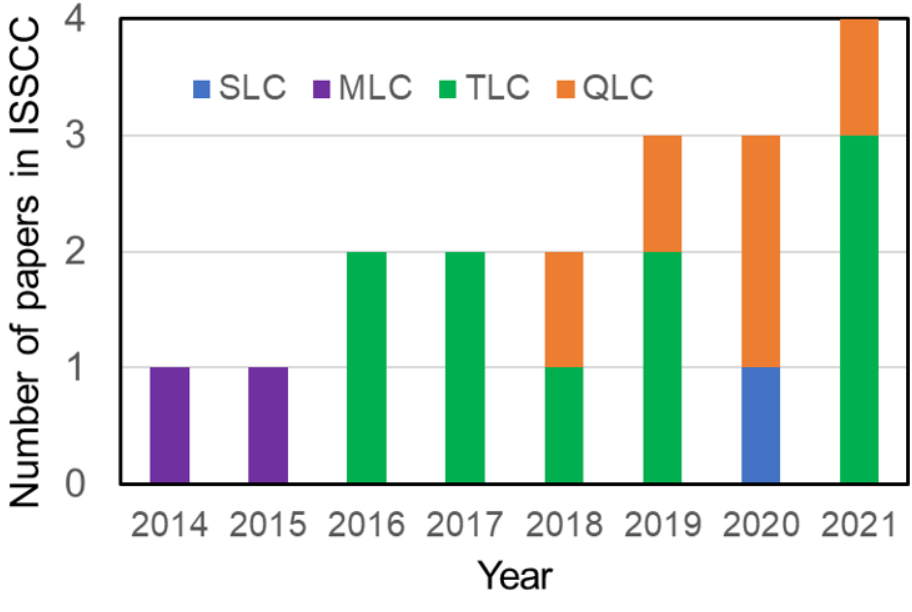
Figure 14. 3D NAND publications in ISSCC for SLC, MLC, TLC and QLC technologies. TLC has been the mainstream for 3D NAND. The interest in QLC is rapidly increasing.